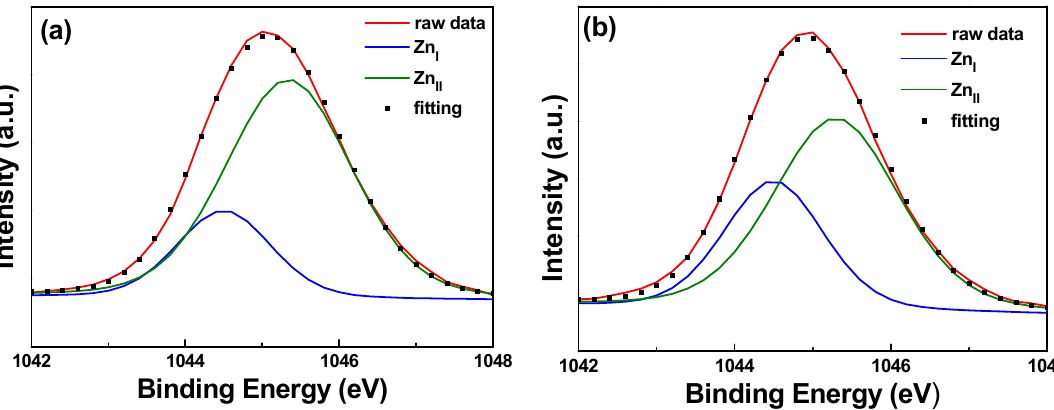
Figure 11. XPS spectra and the Gaussian-resolved components of the Zn 2p 1/2 peak for FZO films on unmodified and 30 s pretreated PI substrates. ( a ) Unmodified and ( b ) O 2 plasma pretreatment time of 30 s. Table 2. Areas of the Zn 2p 1/2 and Zn 2p 3/2 peaks for FZO films on unmodified and 30 s pretreated PI substrates.